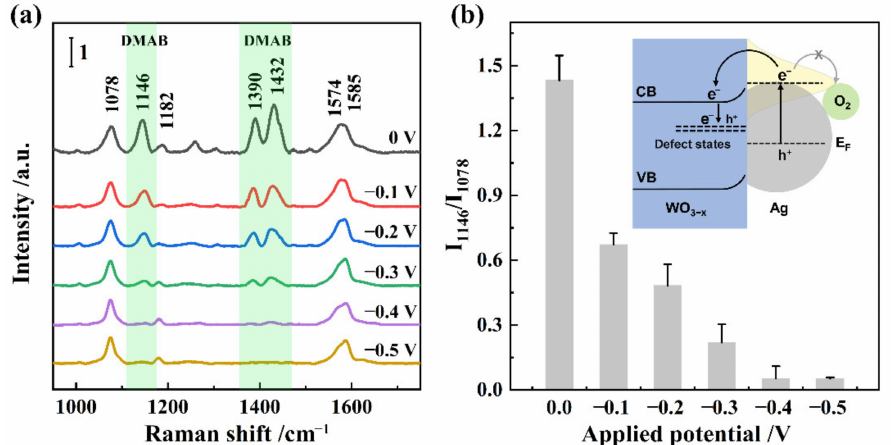
Figure 3. ( a ) SERS spectra of PATP on Ag-WO 3 − x films synthesized with different activated potentials. ( b ) Band intensity ratio (I 1146 /I 1076 ) as a function of activated potential. Inset shows the mechanism of hot electrons transfer in the Ag-WO 3 − x